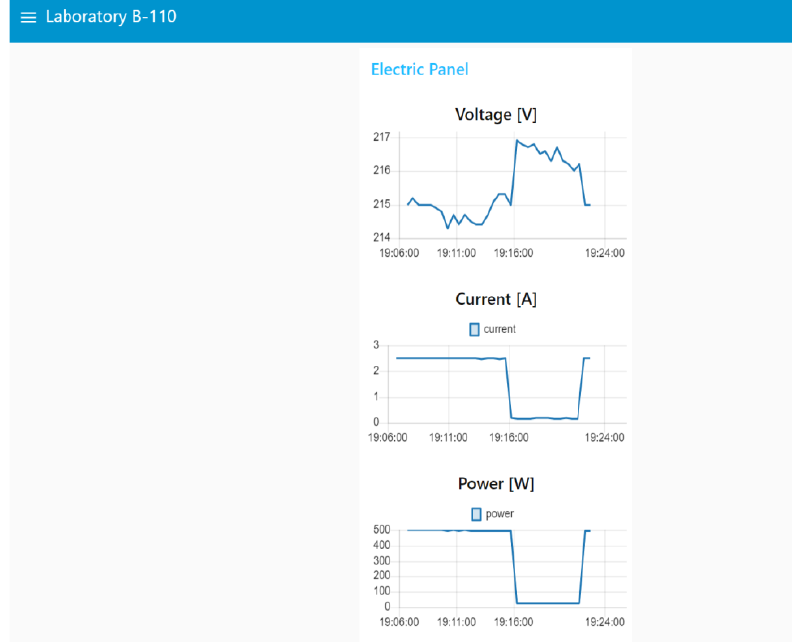
Figure 12. Real-time monitoring data from a laboratory room.